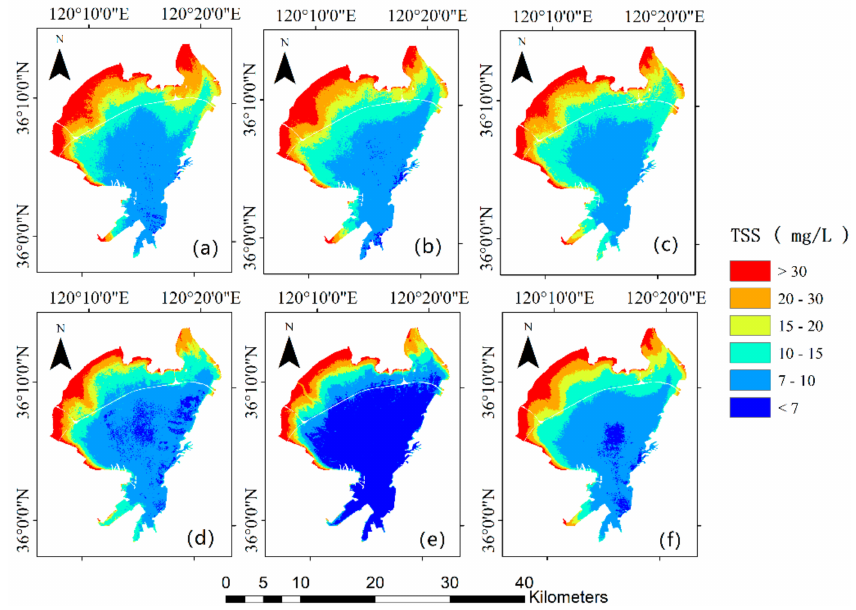
Figure 4. Variation of the average TSS in each period ( a – e ) is the average TSS for period ( a ) to period ( e ); ( f ) is the average TSS for five